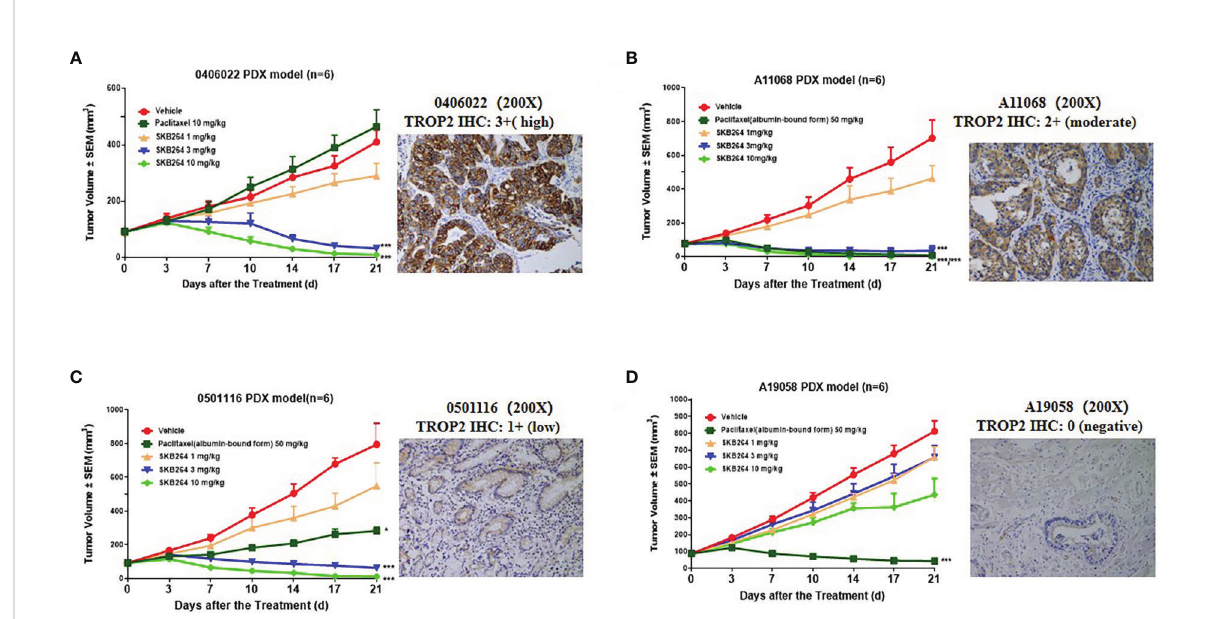
FIGURE 5 In vivo treatment ef fi cacy of the SKB264 in gastric carcinoma PDX models. IHC staining intensity: 0 (Negative): no staining or ≤ 10% tumor cells showing any intensity of cell membrane staining; 1+ (low expression): >10% tumor cells showing weak cell membrane staining; 2+ (moderate expression): >10% tumor cells showing moderate intensity of cell membrane staining; and 3+ (high expression): >10% of tumor cells showing strong cell membrane staining. The tumor-bearing mice were intravenously treated with SKB264 (1, 3, and 10 mg/kg, respectively), vehicle control, and paclitaxel/paclitaxel (albumin-bound form) ( n = 6 per group). On two-tailed paired t -test, *** p < 0.001 and * p < 0.05 ( vs . vehicle). (A) 0406022; (B) A11068; (C) 0501116; and (D)